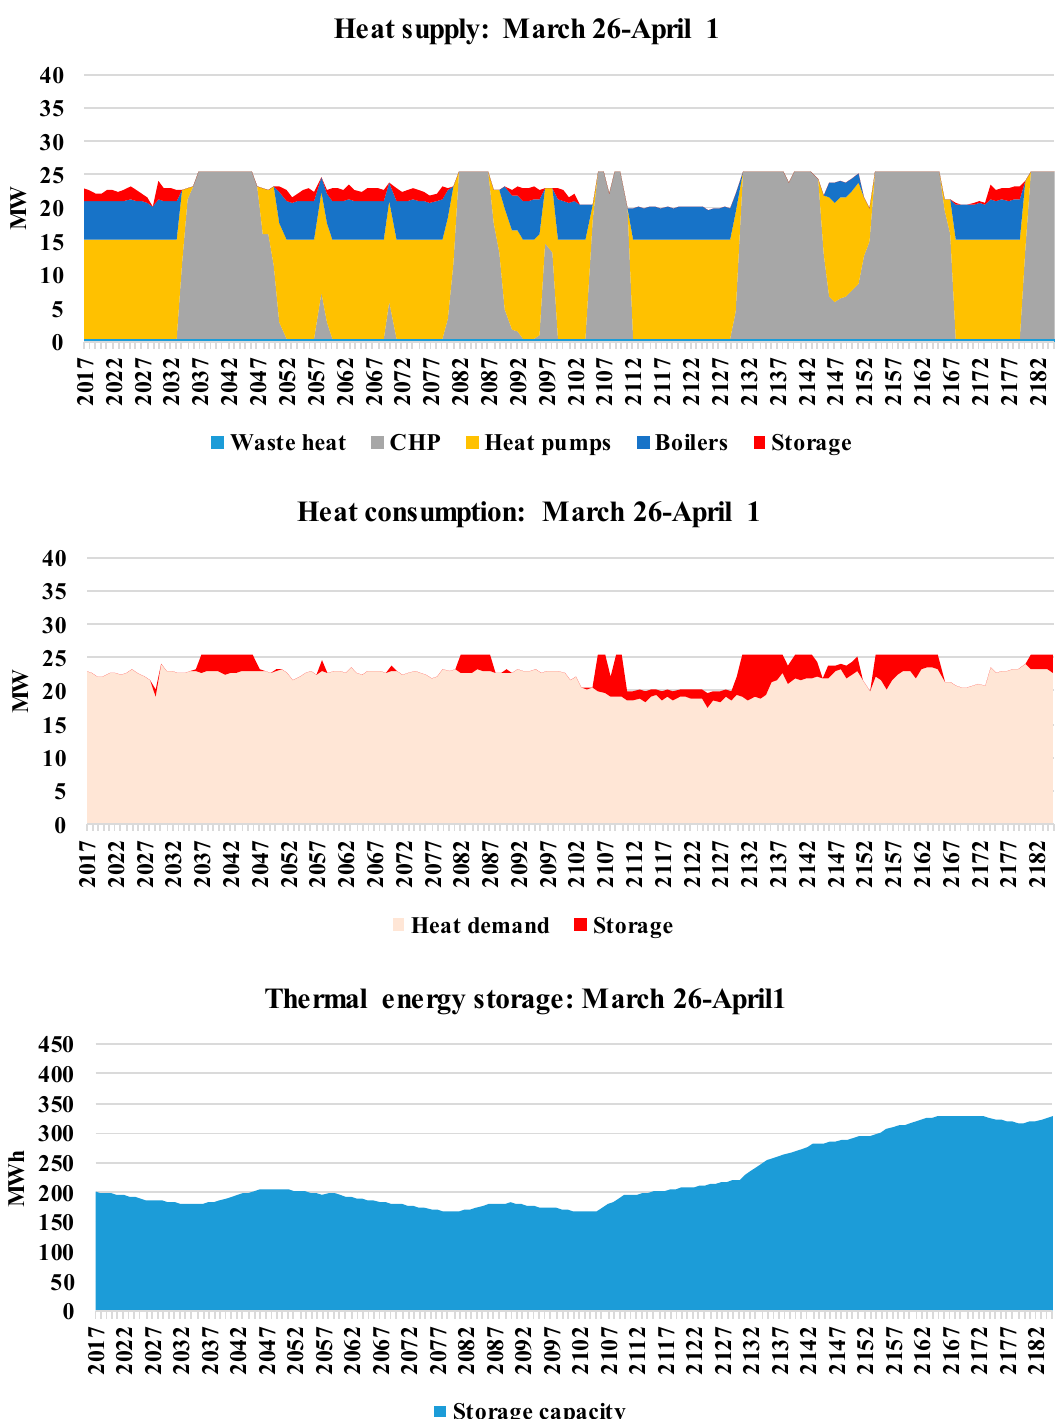
Figure 9. District heat supply ( Top ), consumption ( Centre ), and storage ( Bottom ) for the first study period: 26 March–1 April. Heat pump use is maximized during times of high variable RE generation. CHP plant production satisfies needs for both electricity and heat during evening hours. Utilisation of storage is minimal. Total thermal storage capacity is 1100 MWh th . Thermal storage levels are relatively low at the end of the winter months.